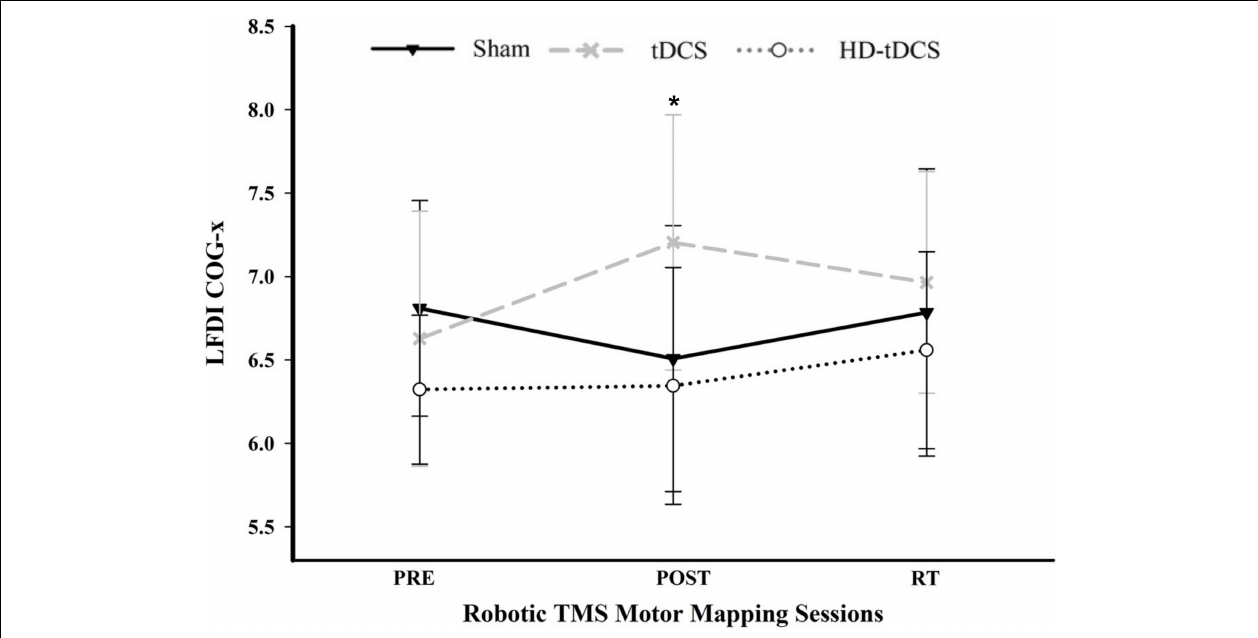
FIGURE 5 | COG-x across mapping sessions. Mean LFDI COG-x (mm) between intervention groups across time points. Change in COG-x significantly differed between tDCS and Sham from the pre-to-post mapping sessions ( p = 0.003). Black line = Sham; Gray dashed line = tDCS; Gray dotted line = HD-tDCS; LFDI = left-hand first dorsal interosseous muscle; COG-x = centre of gravity medial-lateral plane; RT = six-weeks retention time. Error bars = standard deviation. * p <